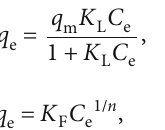
Figure 6: (a ) Nonlinear adsorption isotherm at di ff erent temperature (conditions: MG — 20-350mg/L, time — 120min, Fe O @AJPAL — 50 mg, pH — 7, and agitation — 100rpm) and (b) nonlinear kinetic models for MG adsorption by Fe 3 4 O @AJPAL — 50 mg, pH — 7, temperature — 25 ° C, and agitation — 100 (conditions: MG — 20 mg/L, time — 120min, Fe 3 4 Table 2: Langmuir and Freundlich isotherm models for MG adsorption on Fe O @AJPL nanocomposite 3 4